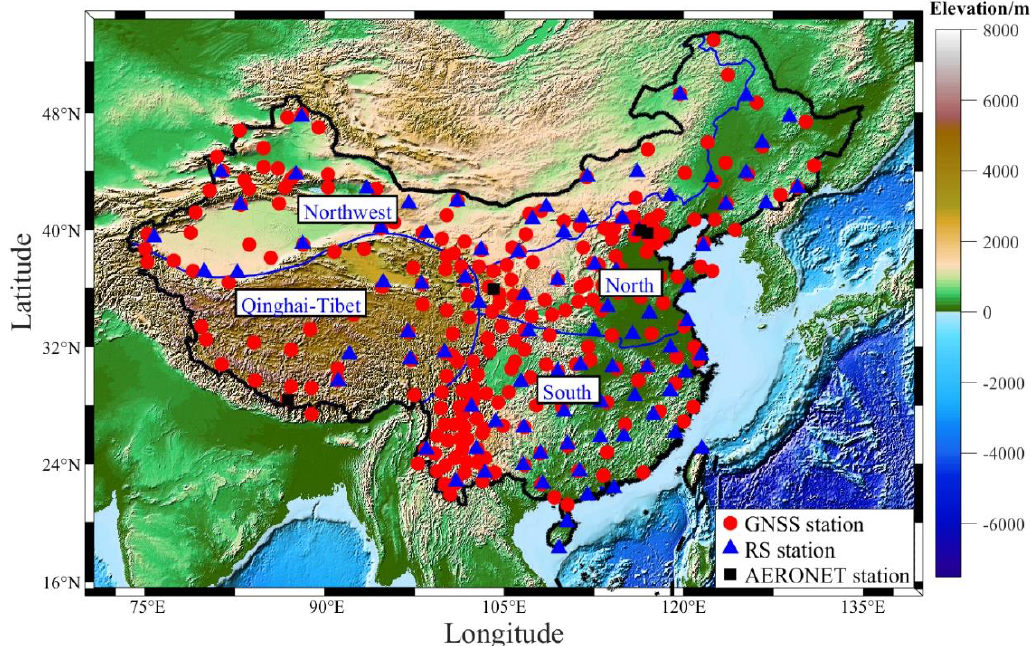
Figure 1. Geographic distributions of Global Navigation Satellite System (GNSS), Radiosonde (RS), and AERONET stations over mainland China. The blue line refers to the boundary line dividing China into four regions. Table 1. Characteristics of datasets selected in the experiment.